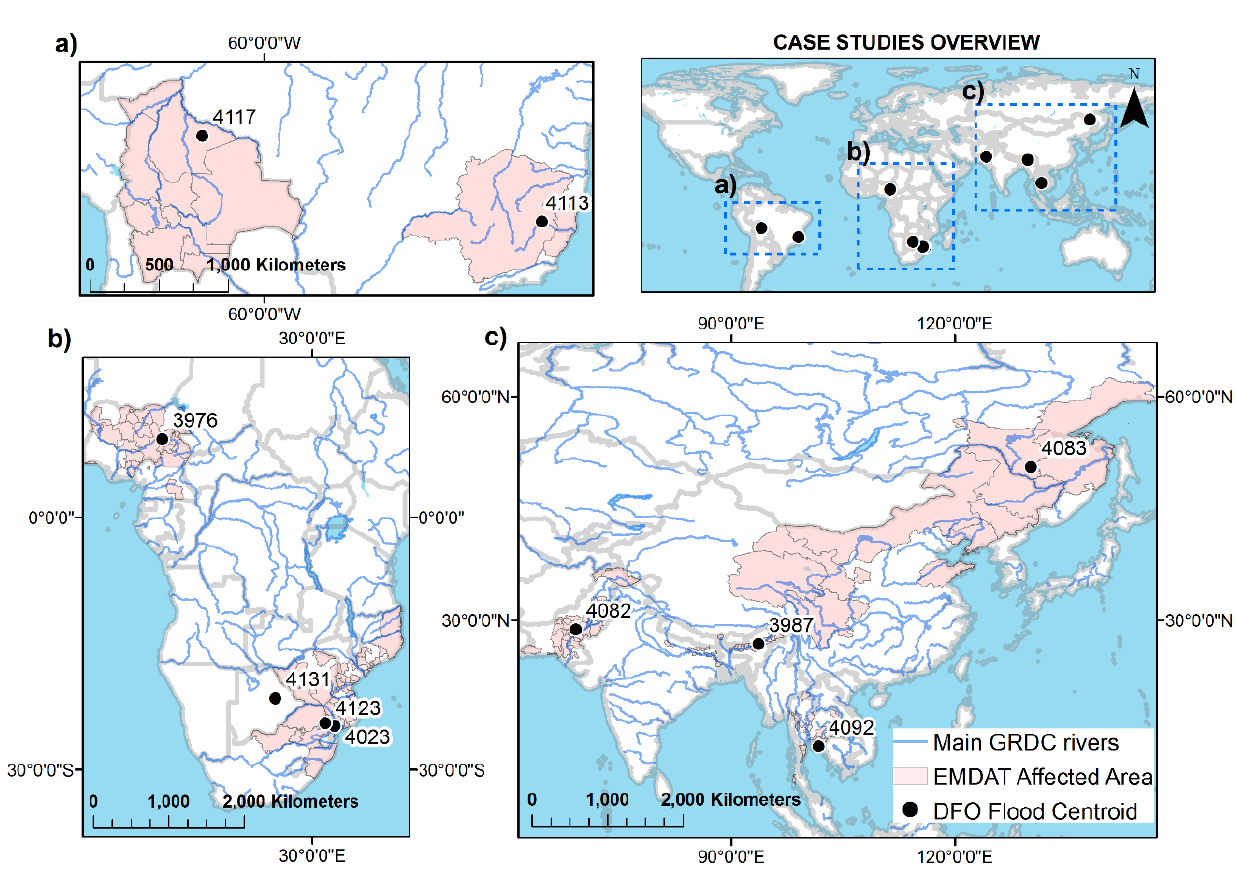
Figure 1. Location of the 10 flood events as recorded in the Dartmouth Flood Observatory with DFO centroid and Id number indicated. The flood-impacted regions from EM-DAT are shown as shaded polygons. Lines represent main GRDC Rivers (blue) and country borders (grey). Panels show ( a ) South America, ( b ) Africa, and ( c )